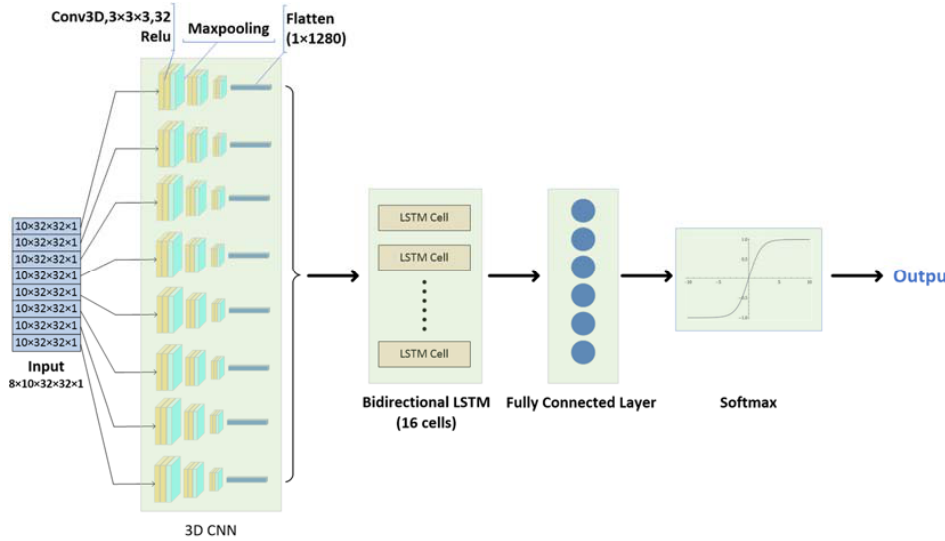
Figure 5. The structure of 3D CNN + LSTM network.